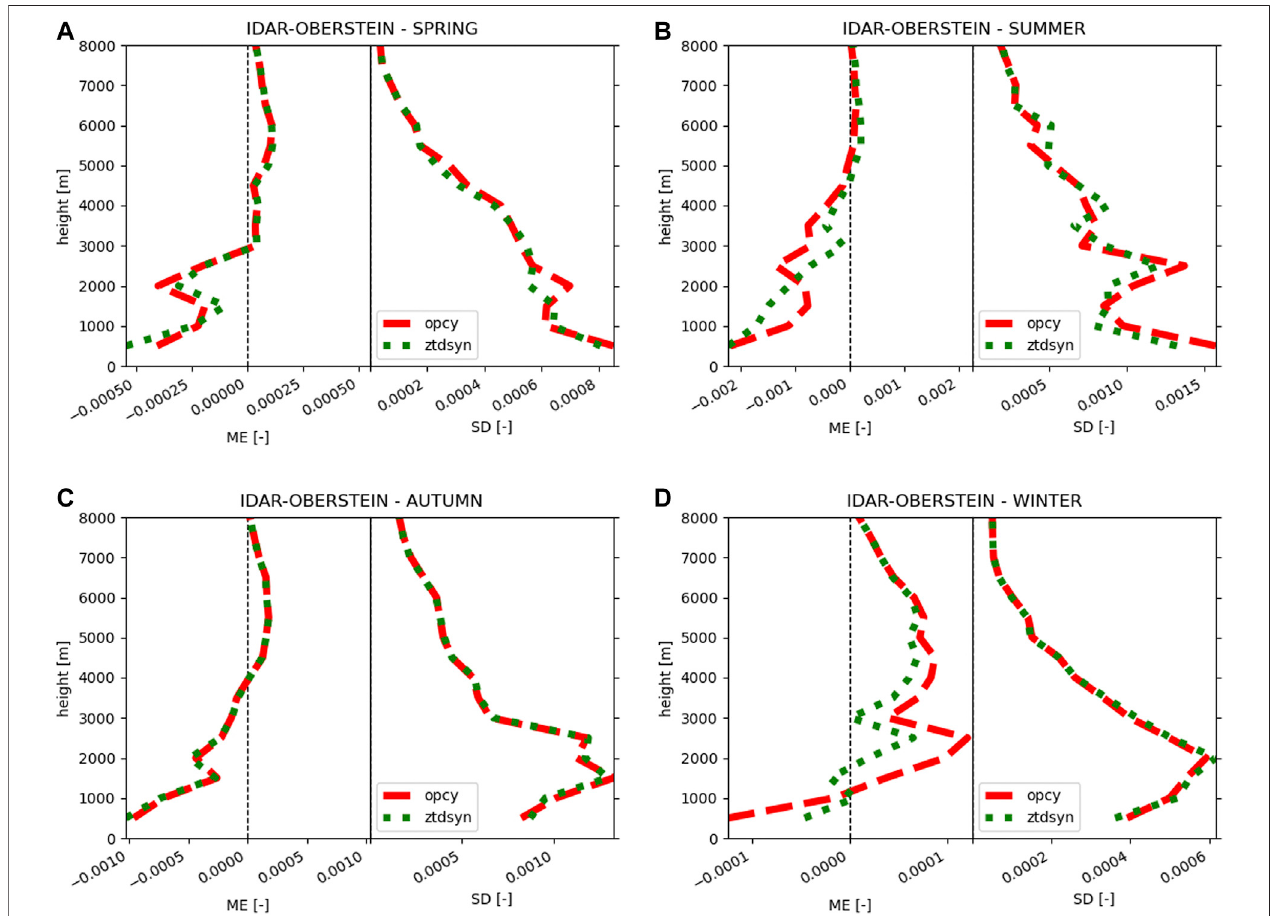
FIGURE12| As in4, but forthe open cycle simulation(red) and the assimilation ofZTDand synoptic data(green) inspring (A) , summer (B) ,autumn (C) and winter (D) at Idar-Oberstein.